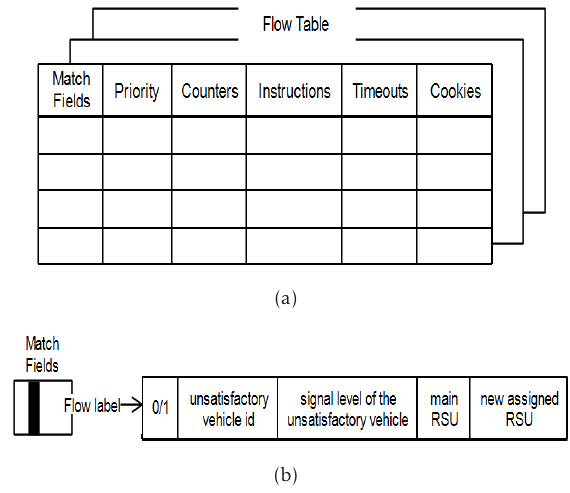
Figure 5. (a) Flow table in OpenFlow (b) Redefined flow label field in match